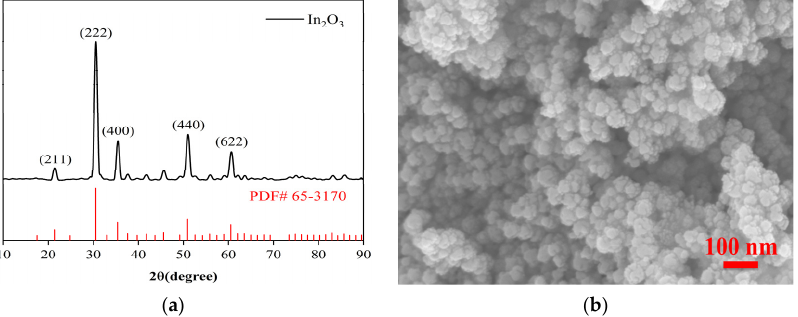
Figure 2. In 2 O 3 nanometer powder characterization picture. ( a ) XRD pattern of In 2 O 3 ; ( b ) FESEM picture of In 2 O 3 nano-powder. picture of In 2 O 3